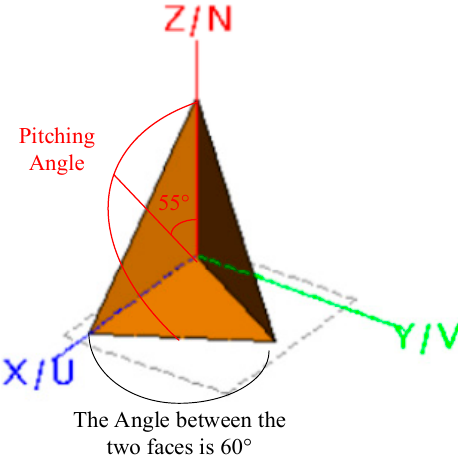
Figure 3. Corner reflector with a side angle of 60°.